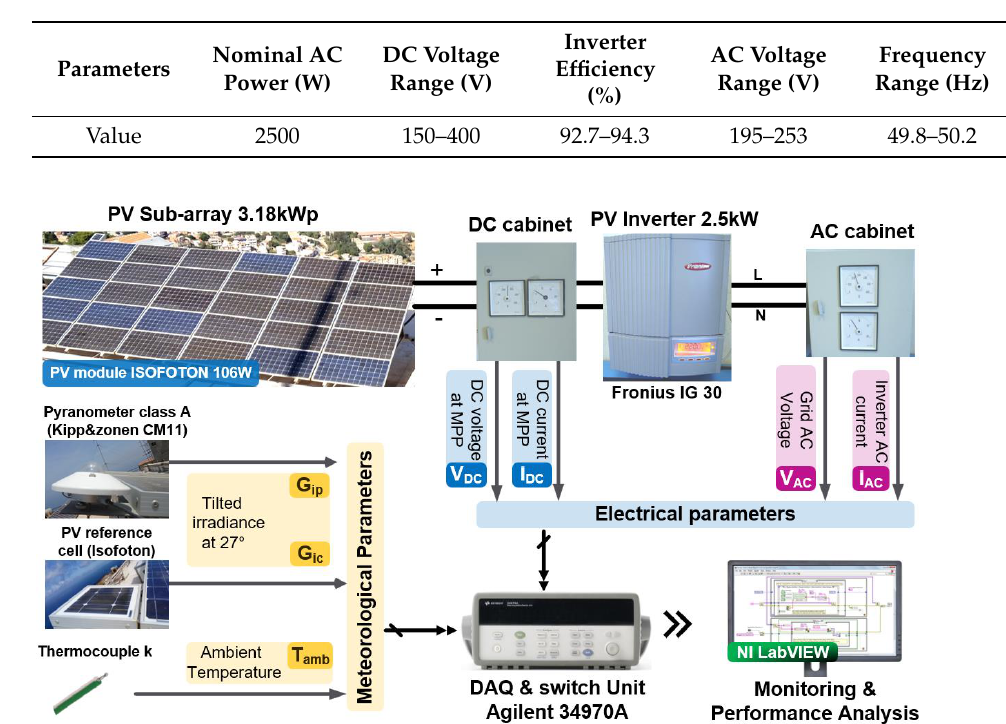
Figure 3. Synoptic diagram of the PV monitoring system.